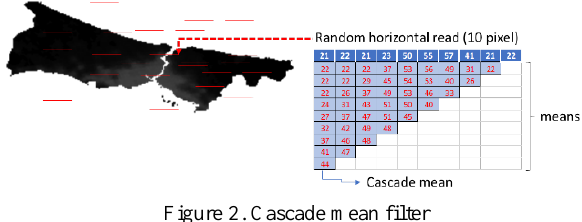
Figure 2. Cascade mean filter